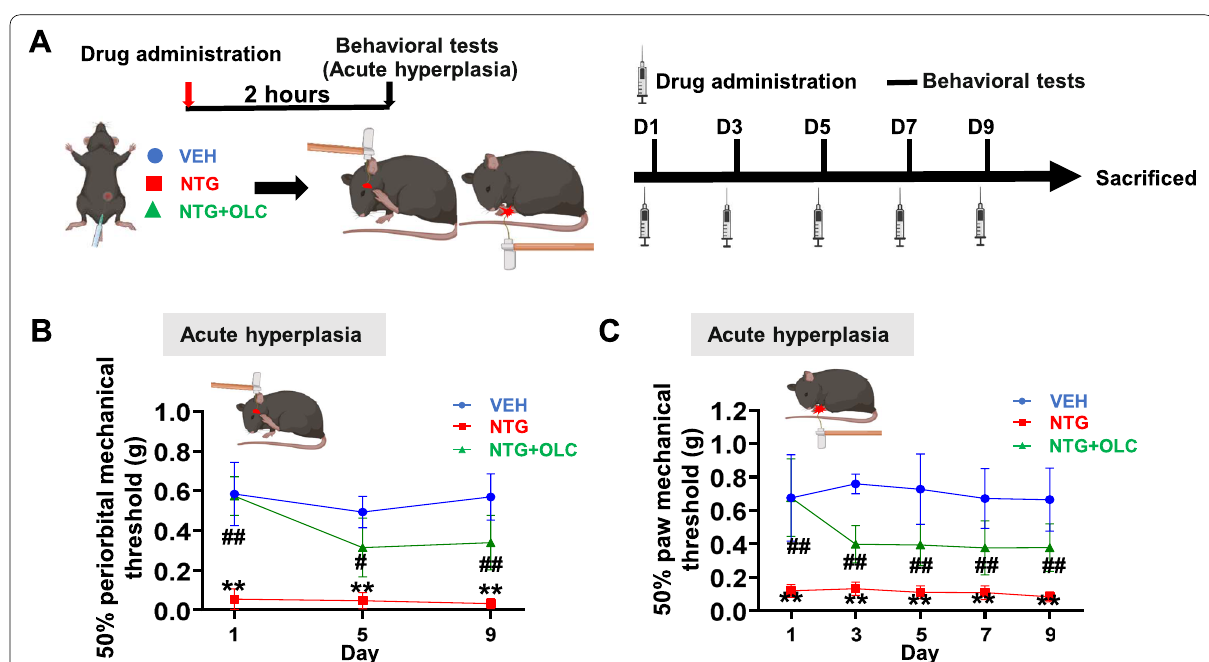
Fig. 1 CGRP receptor antagonist (olcegepant) alleviated acute hyperalgesia in the NTG-induced chronic migraine model. A. Representative schematic diagrams and procedures for the behavioral tests. (Created with BioRender.com) B‑C. Repeated NTG administration induced mechanical hyperalgesia of periorbital area ( B ) and hindpaw ( C ), alleviated by OLC. Two-way ANOVA with the Tukey post hoc tests; * P < 0.05, ** P < 0.01, NTG group compared with the VEH group, n 8/group; # P < 0.05, ## P < 0.01, NTG group compared with the NTG = Abbreviations: VEH, vehicle; NTG, nitroglycerin; OLC,